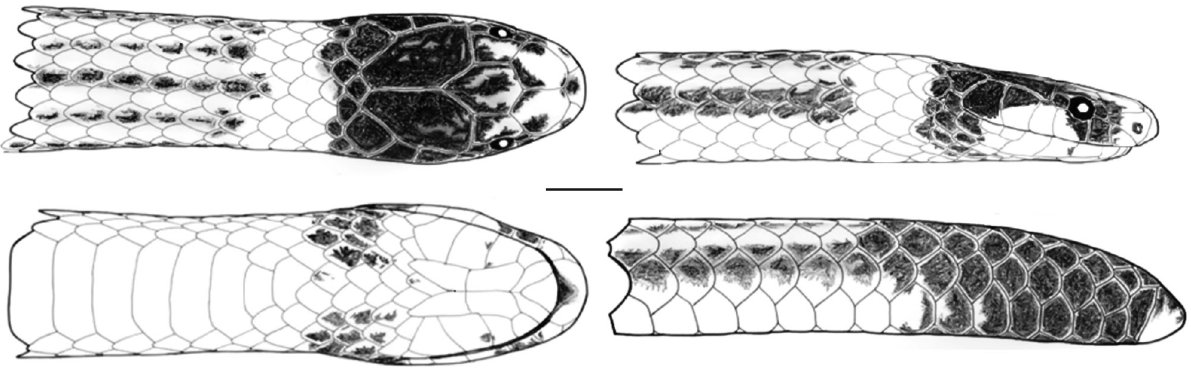
Figure 1. Line drawings from holotype of Apostolepis kikoi sp. nov. (MCP 12096) from the reservoir of Manso hydroelectrical power plant, Chapada dos Guimarães, Mato Grosso, Brazil. Scale bar: 2 mm (Eduardo Melloni Lucchesi